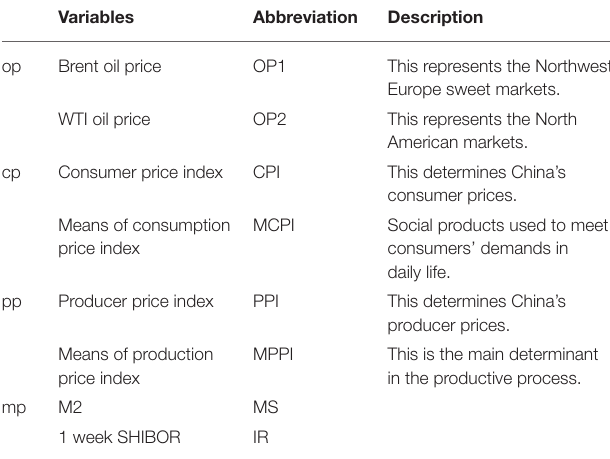
TABLE 1 | Description of all